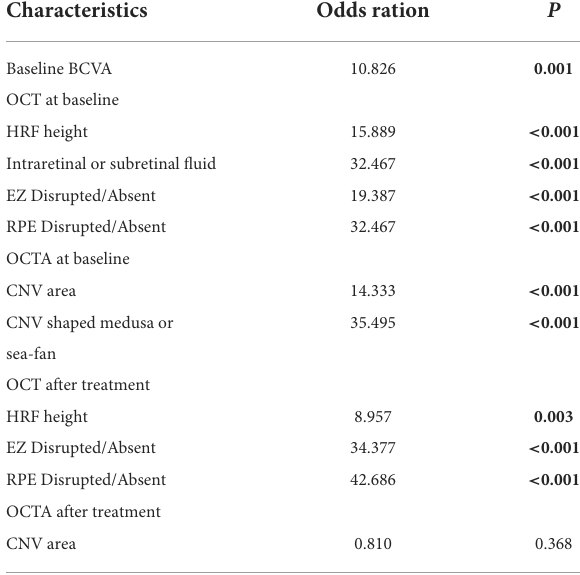
TABLE 4 Spearman correlation analysis to evaluate the correlation between final BCVA and other variables in PM-CNV patients after treatment.